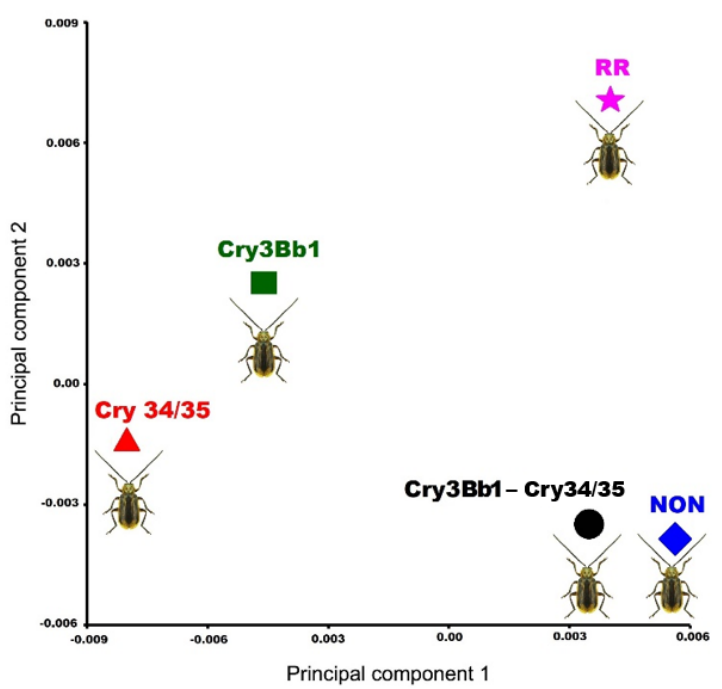
Figure 7. Principal component analysis of the hindwing average shape between different populations: resistant to the toxins, adapted to crop rotation, and non-resistant Diabrotica virgifera virgifera. Color and sign code: red triangle: Cry34/35Ab1 resistant population; green square: CryBb1 resistant population; pink star: population adapted to crop rotation (RR); black circle: CryBb1—Cry34/35Ab1 resistant population; and blue rhomboid (NON): non-resistant population.